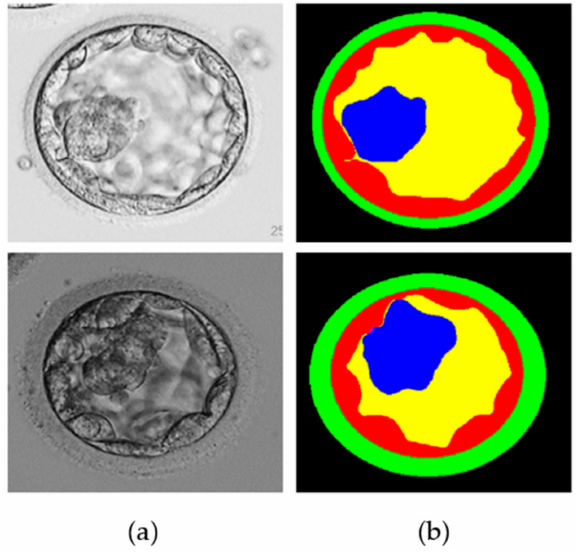
Figure 1. Example microscopic blastocyst image used in the experiments. ( a ) Original images; ( b ) expert annotations for blastocyst components of TE (shown by red color), ZP (shown by green color), ICM (shown by blue color), BL (shown by yellow color), and background (shown by black